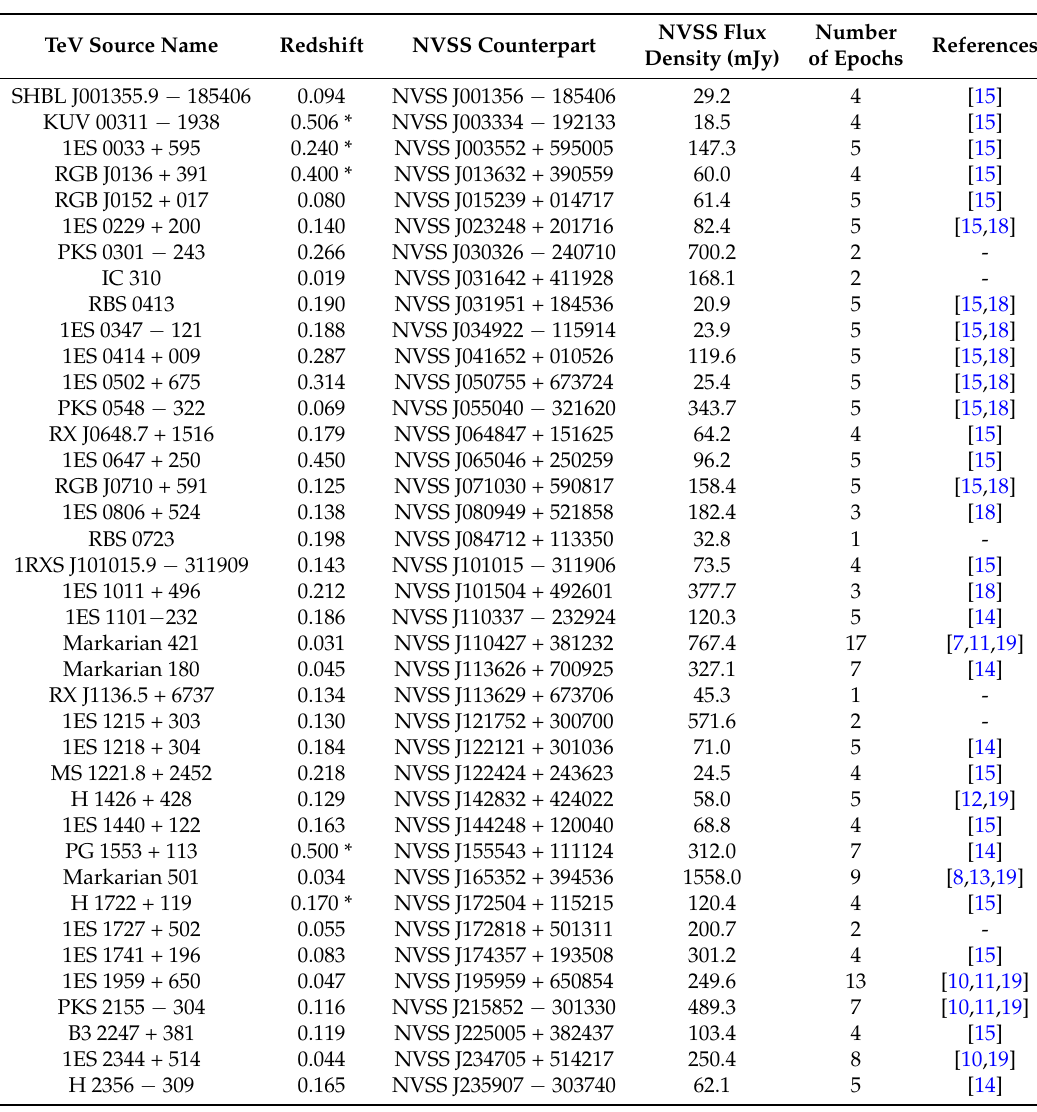
Table 1. Current status of our Very Long Baseline Array (VLBA) monitoring program. TeV source names are those used by TeVCat, redshifts are those given in [15], where an asterisk denotes a tentative value or limit. The NRAO VLA Sky Survey (NVSS) flux density is measured at 1.4 GHz. The number of epochs refers to the number of VLBA images made in our monitoring program. References are to papers presenting these